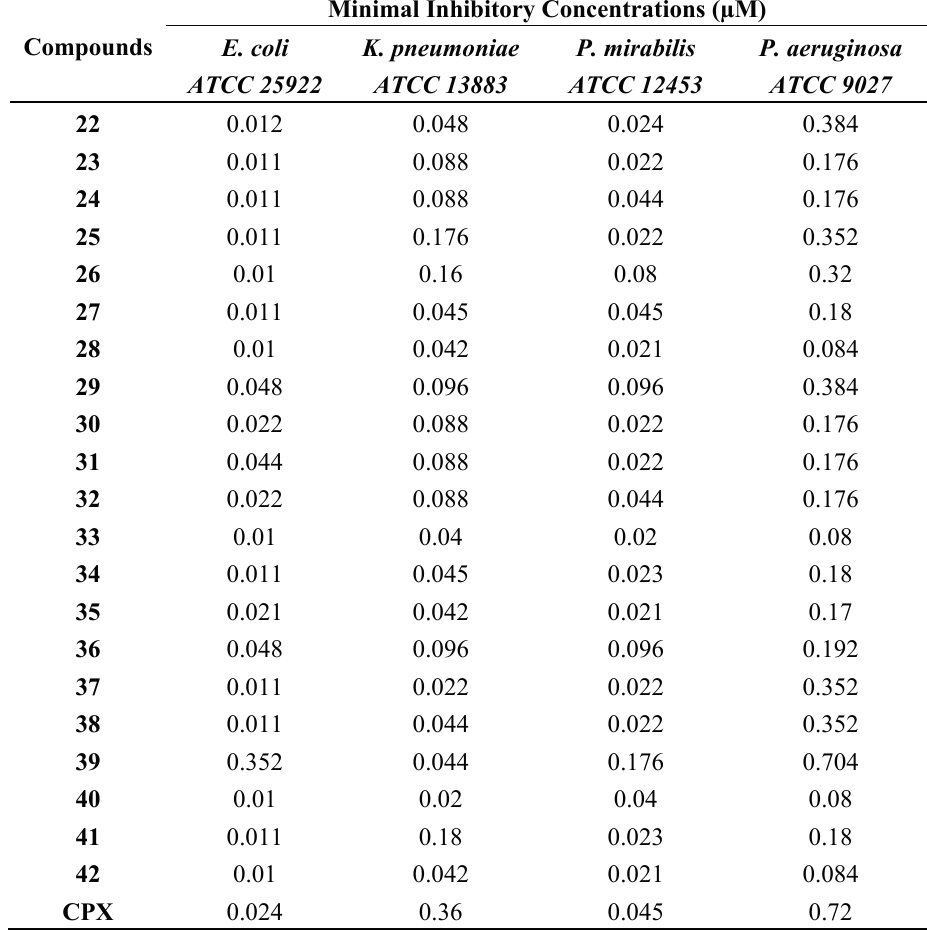
Table 1. Antibacterial activity of compounds 22 – 42 against Gram-negative